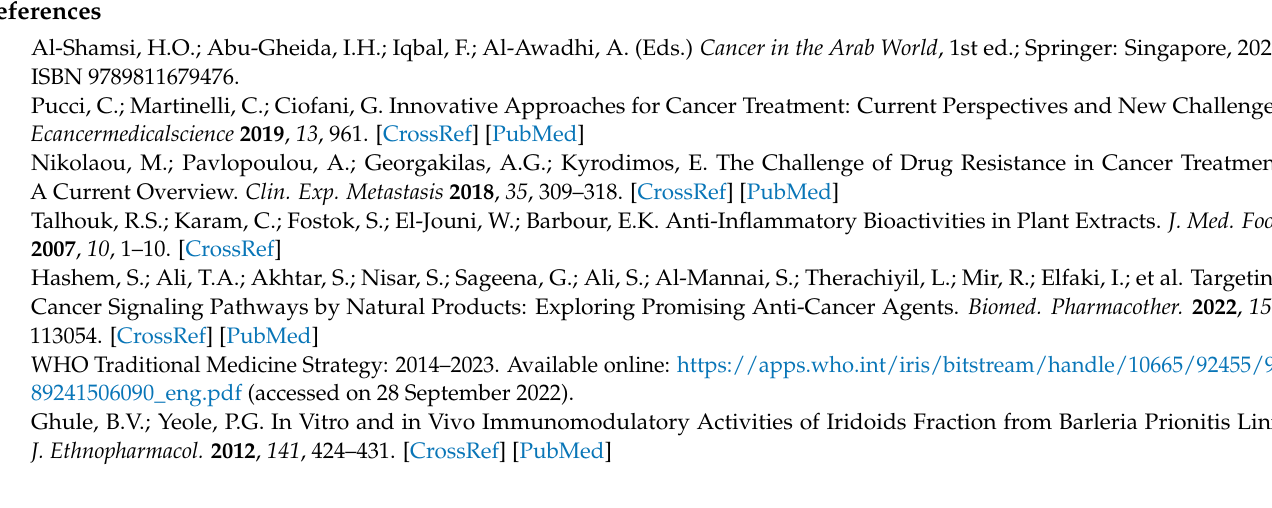
Figure S2. LC-MS analysis peaks of Methanol extract of B. hochstetteri . Figure S3. Cytotoxicity of different solvent extracts of B. hochstetteri against non-cancerous transformed fibroblast L929 cell line. Figure S4. Morphological effects of Hexane extract of B. hochstetteri on non-cancerous transformed fibroblast L929 cell line. Figure S5. Morphological effects of Ethyl acetate extract of B. hochstetteri on non-cancerous transformed fibroblast L929 cell line. Figure S6. Morphological effects of Methanol extract of B. hochstetteri on non-cancerous transformed fibroblast L929 cell line. Figure S7. Morphological effects of aqueous extract of B. hochstetteri on non-cancerous transformed fibroblast L929 cell line. Figure S8. Cytotoxic activity of different solvent extracts of B. hochstetteri against Lung cancer A549 cell line. Figure S9. Cytotoxic activity of different solvent extracts of B. hochstetteri against Breast cancer MCF-7 cell line. Figure S10. Morphological effects of Hexane extract of B. hochstetteri on Lung cancer A549 cell line. Figure S11. Morphological effects of Ethyl acetate extract of B. hochstetteri on Lung cancer A549 cell line. Figure S12. Morphological effects of Methanol extract of B. hochstetteri on Lung cancer A549 cell line. Figure S13. Morphological effects of Aqueous extract of B. hochstetteri on Lung cancer A549 cell line. Figure S14. Morphological effects of Hexane extract of B. hochstetteri on Breast cancer MCF-7 cell line. Figure S15. Morphological effects of Ethyl acetate extract of B. hochstetteri on Breast cancer MCF-7 cell line. Figure S16. Morphological effects of Methanol extract of B. hochstetteri on Breast cancer MCF-7 cell line. Figure S17. Morphological effects of Aqueous extract of B. hochstetteri on Breast cancer MCF-7 cell